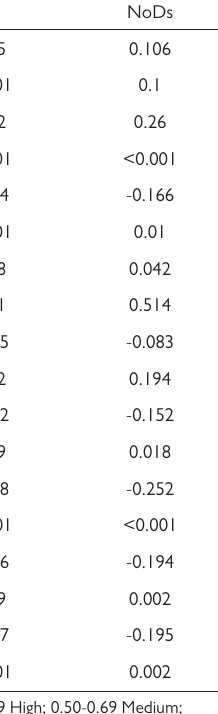
Table 3. Correlation Analysis Between Patients’ Descriptive Data and Katz ADL, CCI, and Number of Drugs Taken by Participants in All Groups